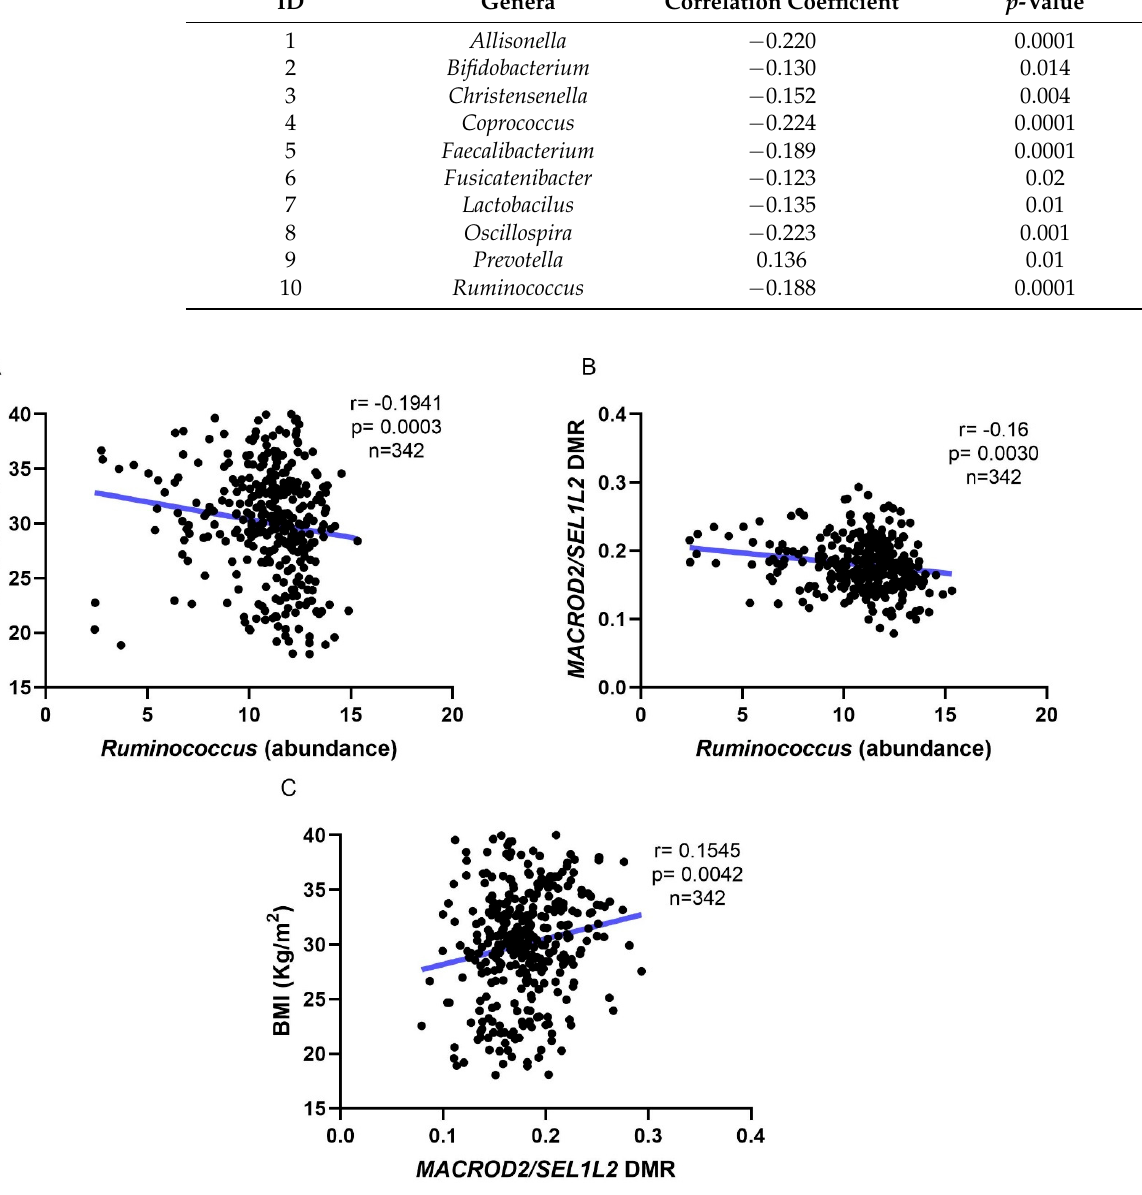
Figure 1. Correlations between bacterial abundance, BMI, and DMR. ( A ) Correlation between BMI and Ruminococcus abundance; ( B ) correlation between MACROD2/SEL1L2 DMR and Ruminococcus abundance; ( C ) correlation between BMI and MACROD2/SEL1L2 DMR. Dots indicate each sample analyzed. Line indicates the correlation tendency. ( n = 342 subjects).